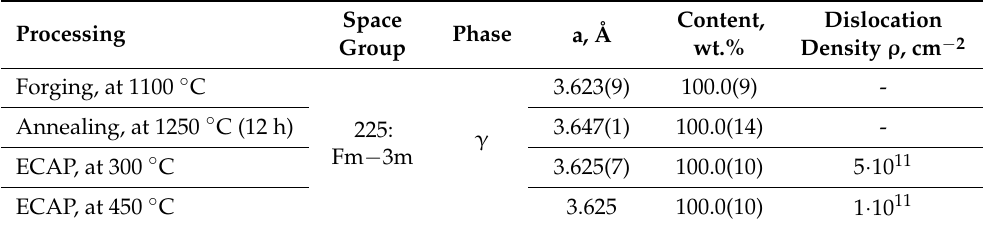
The structure of the alloy after ECAP at 450 ◦ C has a five times lower dislocation density compared to the alloy samples after ECAP at 300 ◦ C, which is explained by a higher deformation temperature at the same equivalent cumulative